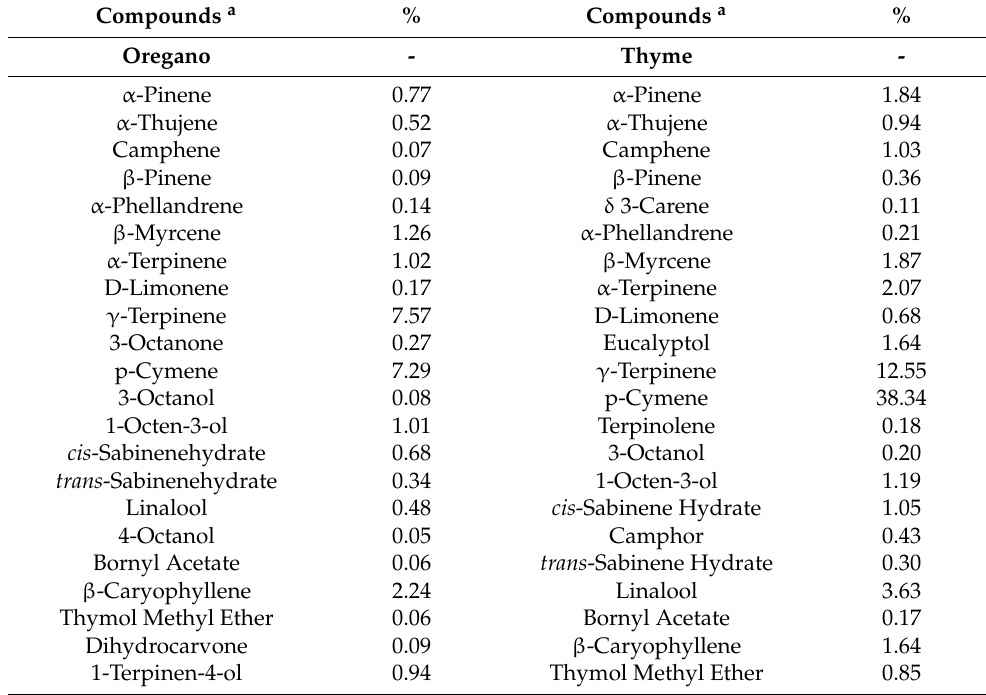
Table 3. Composition (%) of oregano and thyme essential